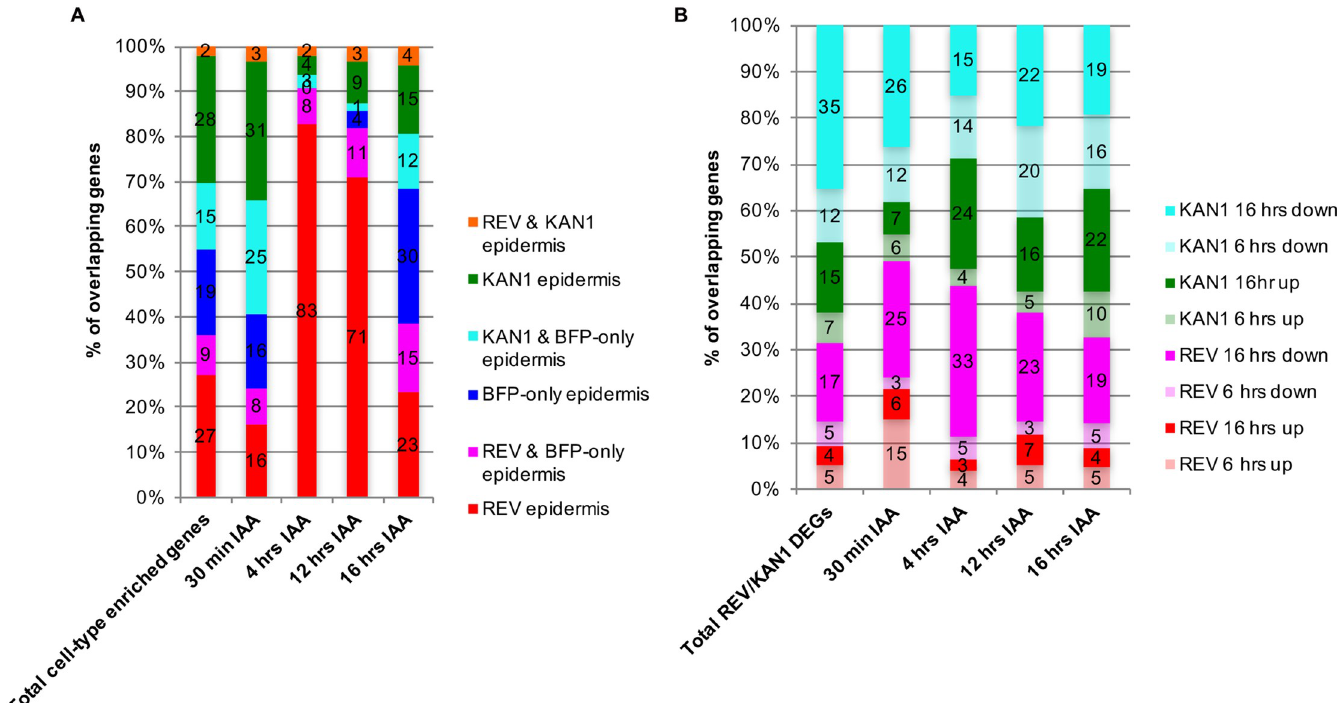
Fig 5. Proportion of auxin responsive genes that are cell-type enriched and responsive to changes in REV and KAN1 expression. (A) Overlap between the set of genes expressed in a cell-type-specific manner and genes responsive to auxin. First bar represents genes enriched in each particular cell-type as a proportion of the total genes that show cell-type specific enrichment (including genes unresponsive to auxin), shown by the color and percentage. Subsequent bars represent the same information but for genes that are up-regulated by auxin at specific time points (see x-axis). Note that the data for auxin up-regulated genes should be compared to the data for all cell-type specific genes (first column). (B). First bar represents genes responsive to REV or KAN1 at different time points (see color legend adjacent to bars) as a proportion of the total number of genes responsive to REV and KAN1 (including genes unresponsive to auxin), shown by the color and percentage. Subsequent bars represent the same information but for genes that are up-regulated by auxin at specific time points (see x-axis). Note that the data for auxin up-regulated genes should be compared to the data for all REV and KAN1 regulated genes (first column).